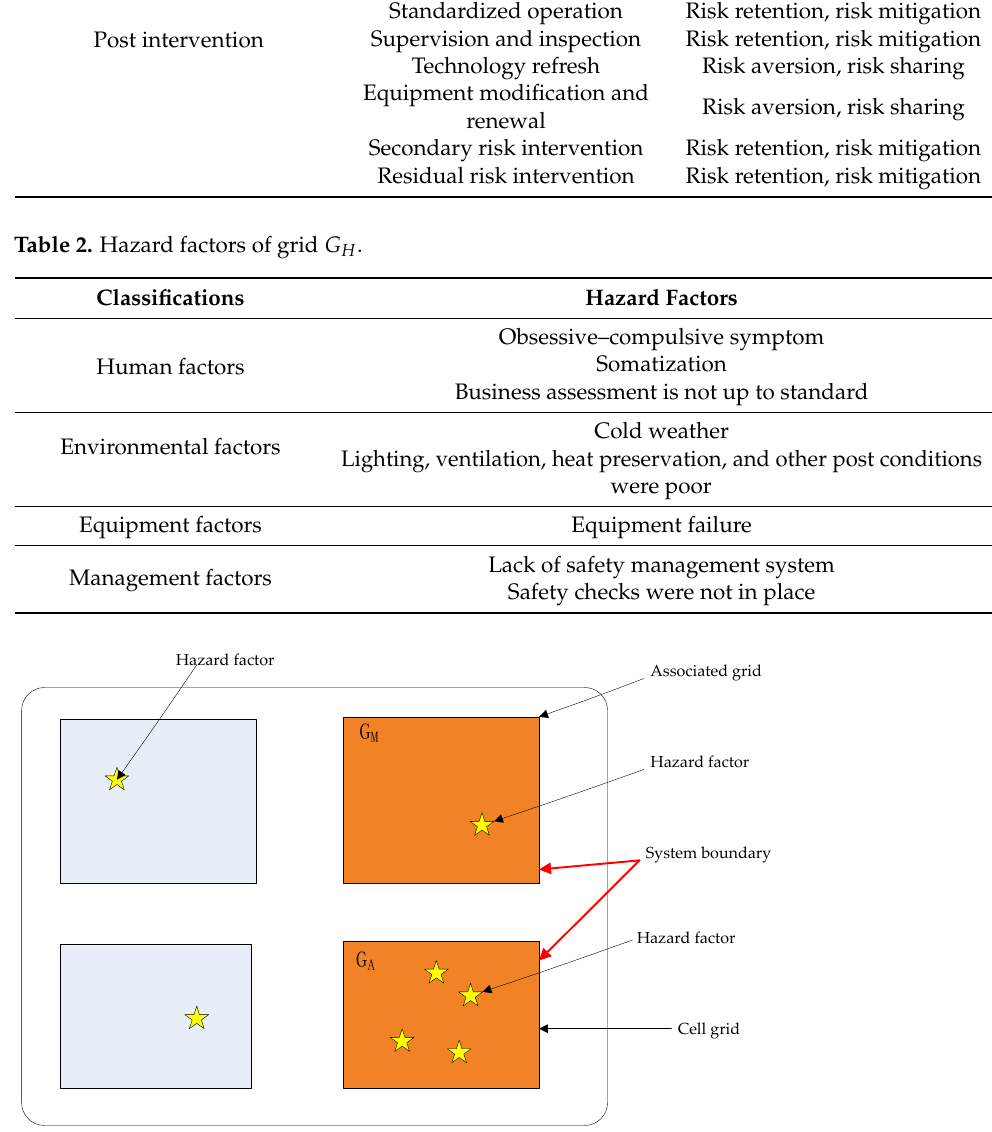
Figure 7. System boundary diagram of grid G H Figure 6. System boundary diagram of grid H